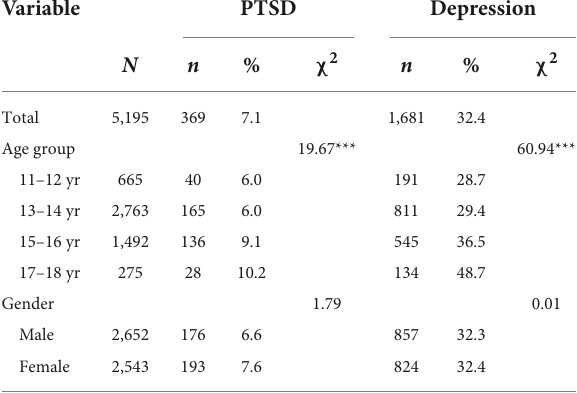
TABLE 3 Hierarchical multiple regression to identify the factors associated with depressive symptoms in adolescents experiencing multiple difficulties ( N = 5,195) a